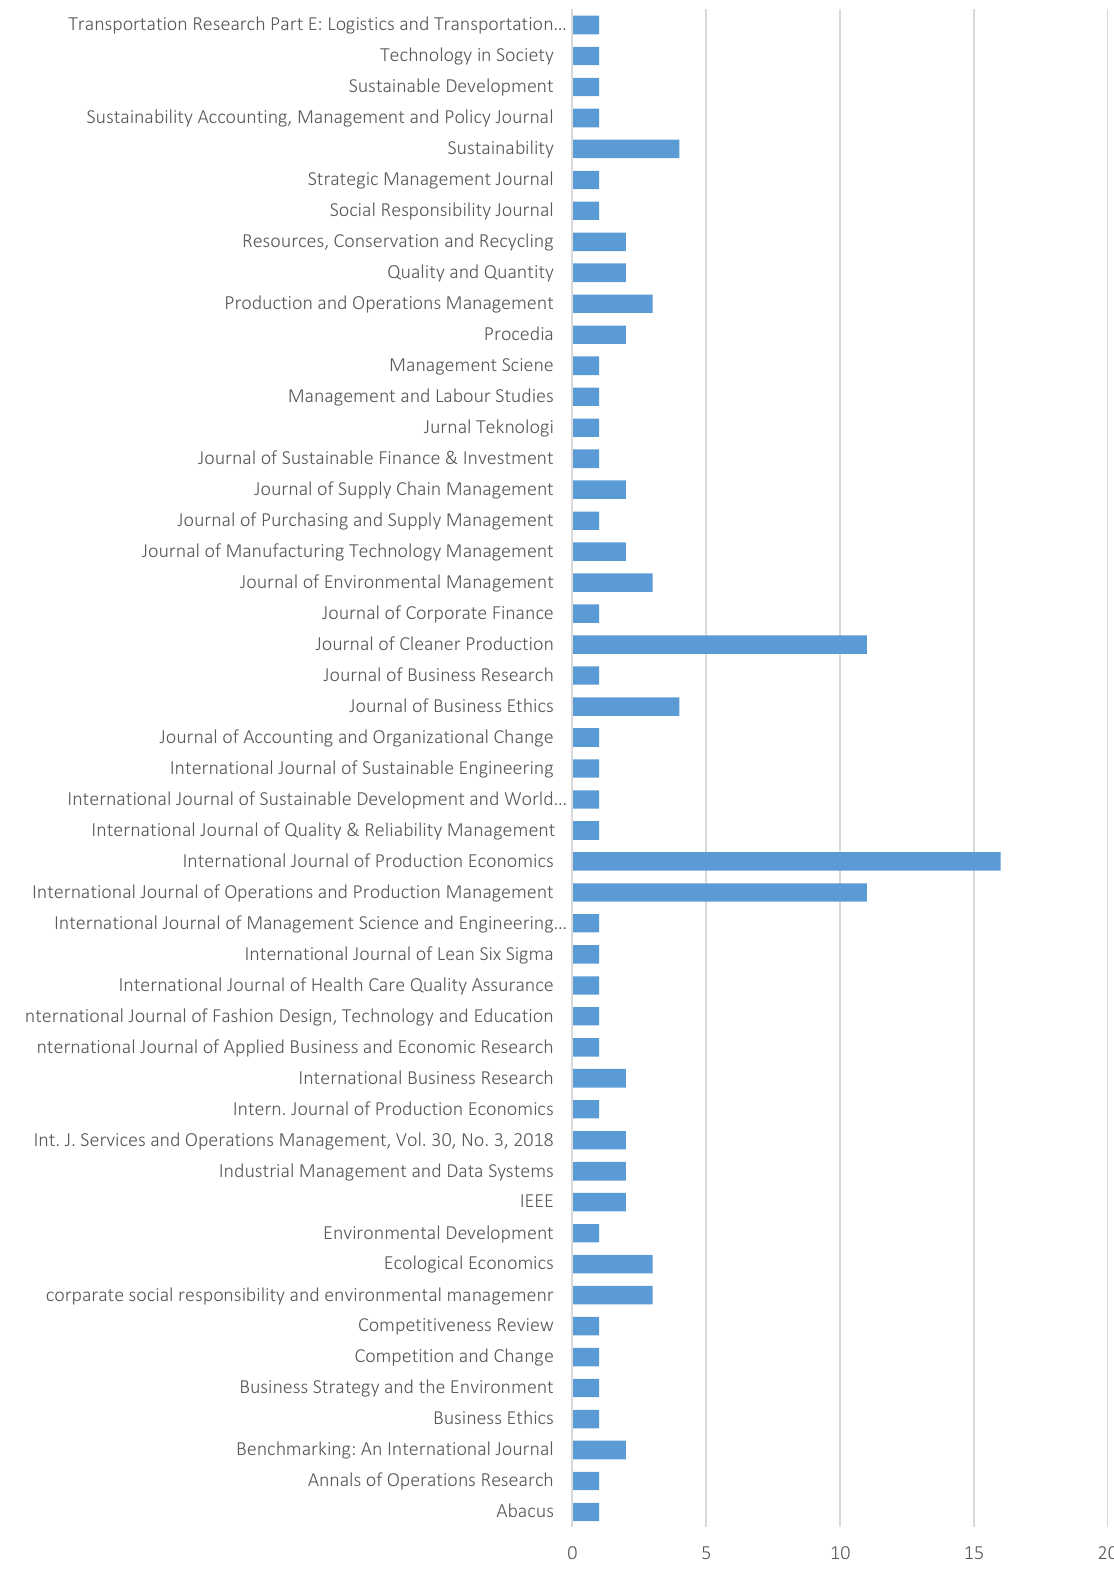
Figure 2. The distributions of journal